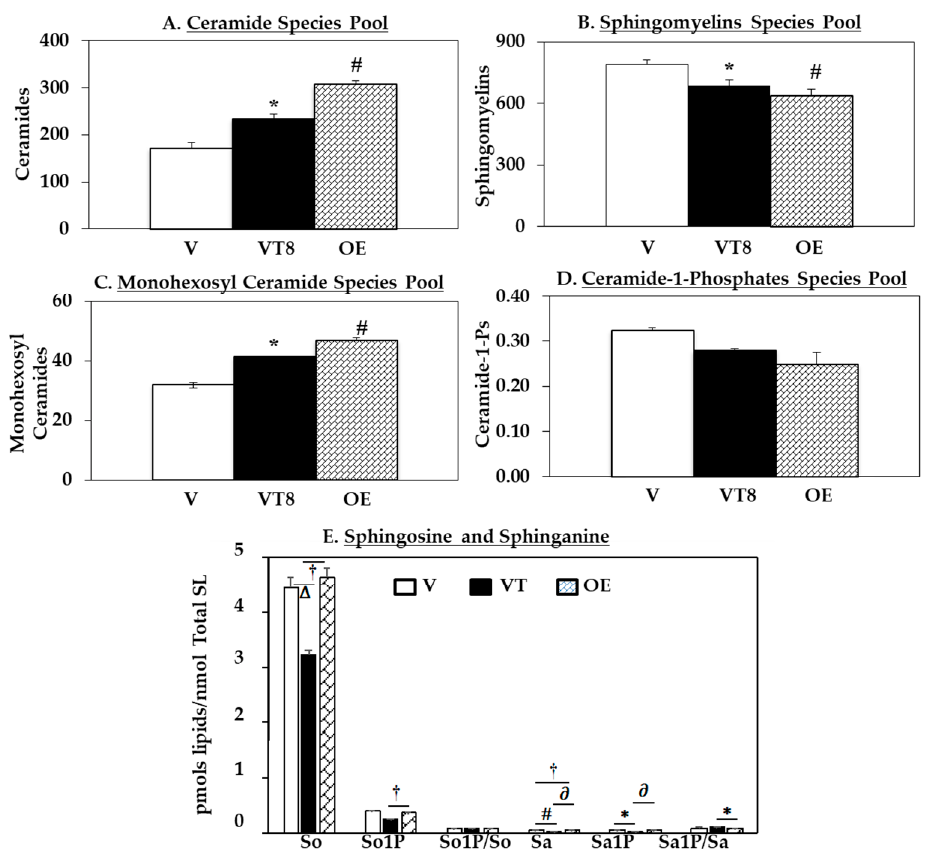
Figure 2. Sphingolipid (SL) abundances in INS-1 cells ± ER stress. Lipids were extracted from empty vector INS-1 cells treated with DMSO (V) or thapsigargin (T, 1 µ M for 8 h, (VT8)) and iPLA 2 β -overexpressing (OE) INS-1 cells for LC ESI/MS/MS analyses: ( A ) Ceramide pool; ( B ) Sphingomyelin pool; ( C ) Monohexosyl ceramide pool; ( D ) Ceramide-1-phosphate pool; ( E ) Sphingosine and sphinganine. Data are presented as mean ± SEM pmols lipid/nmol total sphingolipid). One-Way ANOVA was utilized for statistical analysis. ( A – D ), * OE group significantly different from V and # VT group significantly different from V; p < 0.05; ( E ), * p < 0.05, † p < 0.01, ∆ p < 0.005, ∂ p < 0.0005, # p < 0.0001, n = 3 per group).